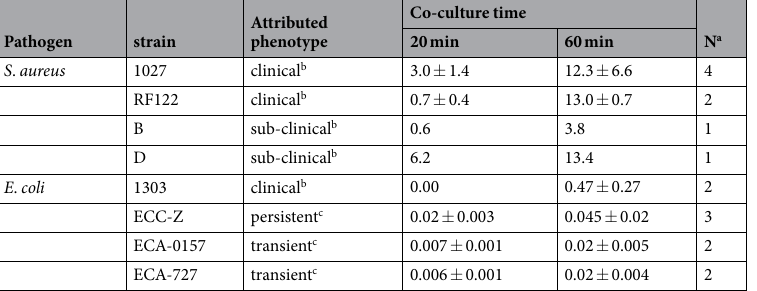
Table 3. Invasion of pathogens into MAC-T cells. Values represent mean percentages ( ± SEM) of the inoculum found inside the cells after co-culturing pathogen and host cells for the times as indicated. a Number of independent experiments, each assayed in duplicate. b Originally isolated from clinical or sub-clinical cases of mastitis, cf ref. 65; c was shown to cause transient or persistent infection of udder cells, cf ref.